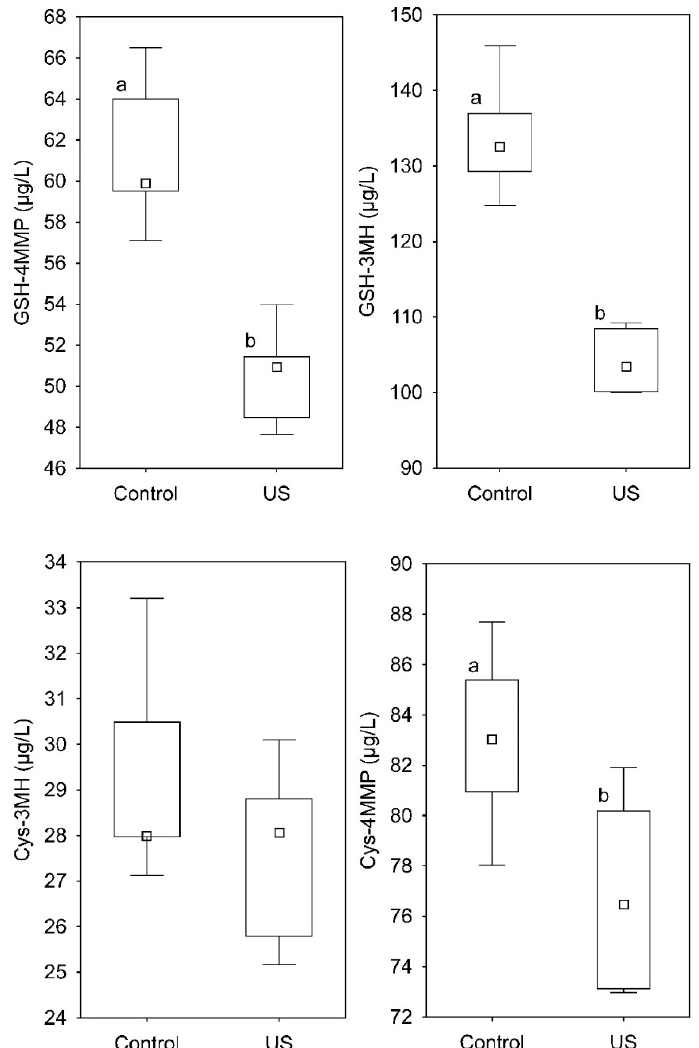
Figure 3. Concentration distribution of 3-S-glutathionyl mercaptohexan-1-ol (GSH-3MH), 3-S-cysteinyl mercaptohexan-1-ol (Cys-3MH), 3-S-glutathionyl mercapto-4-methyl-pentan-2-one (GSH-4MMP), and 3-S-cysteinyl mercapto-4-methyl-pentan-2-one (Cys-4MMP) in the model solution of control and treated (US) samples after 5 min of sonication. Different letters indicate mean values statistically differentiated.